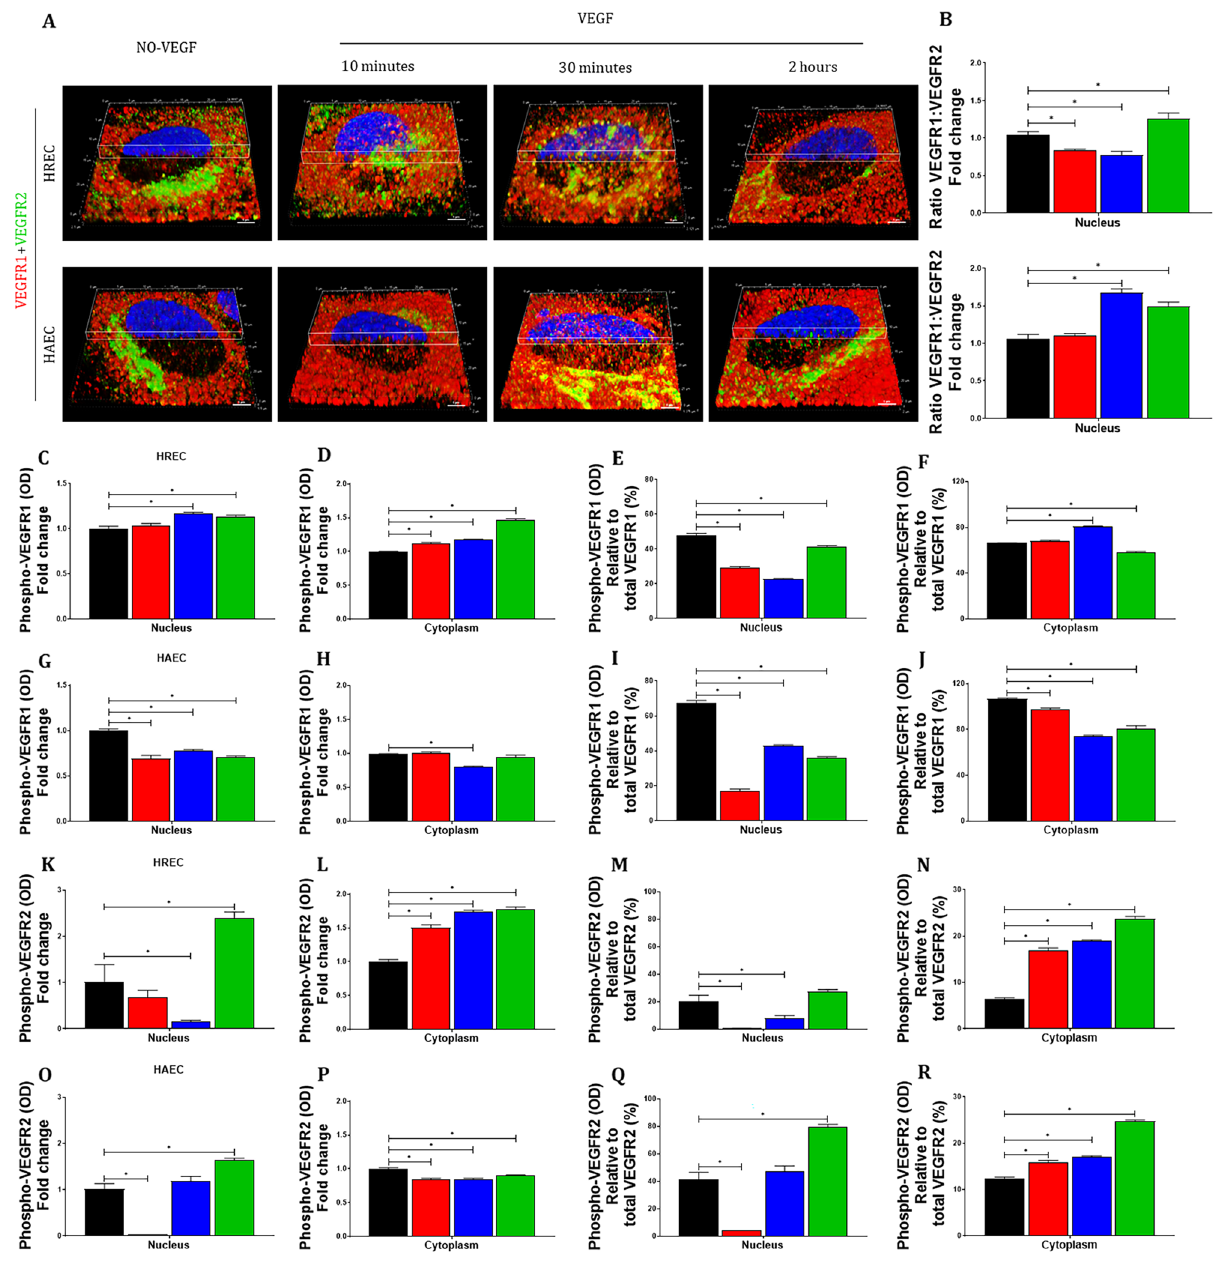
Figure 3. The nuclear VEGFR1:VEGFR2 ratio is different in micro- and macrovascular endothelial cells and VEGF-stimulated nuclear VEGFRs are minimally phosphorylated . The nuclear levels of VEGFR1 and VEGFR2 plus of phospho-VEGFR1 and phospho-VEGFR2 in HREC and HAEC were evaluated by double immunofluorescence and sandwich ELISA, respectively, at different time points (10 min, 30 min and 2 h) after exposure to 100 ng/ml VEGF and compared to untreated controls (NO-VEGF). ( A ) Representative 3D reconstruction rendering images of the HREC and HAEC after VEGF treatment and control immunostained for full length VEGFR1 (red) + C-terminal VEGFR2 (green) showing simultaneous nuclear localization of both receptors after VEGF treatment. The nuclei were fluorescently stained with the DNA intercalating dye Hoechst (blue) and the blue channel was partially removed from the 3D representations to evidence the simultaneous localization and association of VEGFR1 and VEGFR2 in the area corresponding to the nucleus. The associated points that spatial colocalize green and red are shown in yellow. Scale bars = 5 μm. ( B ) Graphic representation of the nuclear VEGFR1:VEGFR2 ratio of HREC and HAEC following addition of VEGF shown in A after the quantification of the median intensity of fluorescence (MIF) of at least 10 confocal z-stack images at 400 × magnification for each experiment performed using NIS elements software. VEGFR1:VEGFR2 ratio graphs represent VEGF time point fold change with respect to control NO-VEGF and the graphs bars represents the average of the a minimum of 3 separate experiments from HREC and HAEC. Graphs showing the quantification of the phospho-VEGFR1 ( C–D , G–H) and phospho-VEGFR2 ( K–L , O–P ) present in nuclear ( C , G , K and O ) and cytoplasmic ( D, H, L and P ) fractions of the HREC and HAEC after VEGF treatment and control quantified by sandwich ELISA. ( E–F , I–J , M–N , Q–R ) graphic representation of the phospho-VEGFR1 and phospho-VEGFR2 percentage relative to total amount of VEGFR1 or VEGFR2 found in the nucleus and cytoplasm of the HREC and HAEC following addition of VEGF. ELISA data for each VEGF time point was normalized by the control NO-VEGF and bars represent the average of the a minimum of 3 separate experiments from 3 donors of the HREC and 2 donors of the HAEC. * = p < 0.05 as determined by 1-way ANOVA and multi-comparison post-hoc Tukey’s test was considered